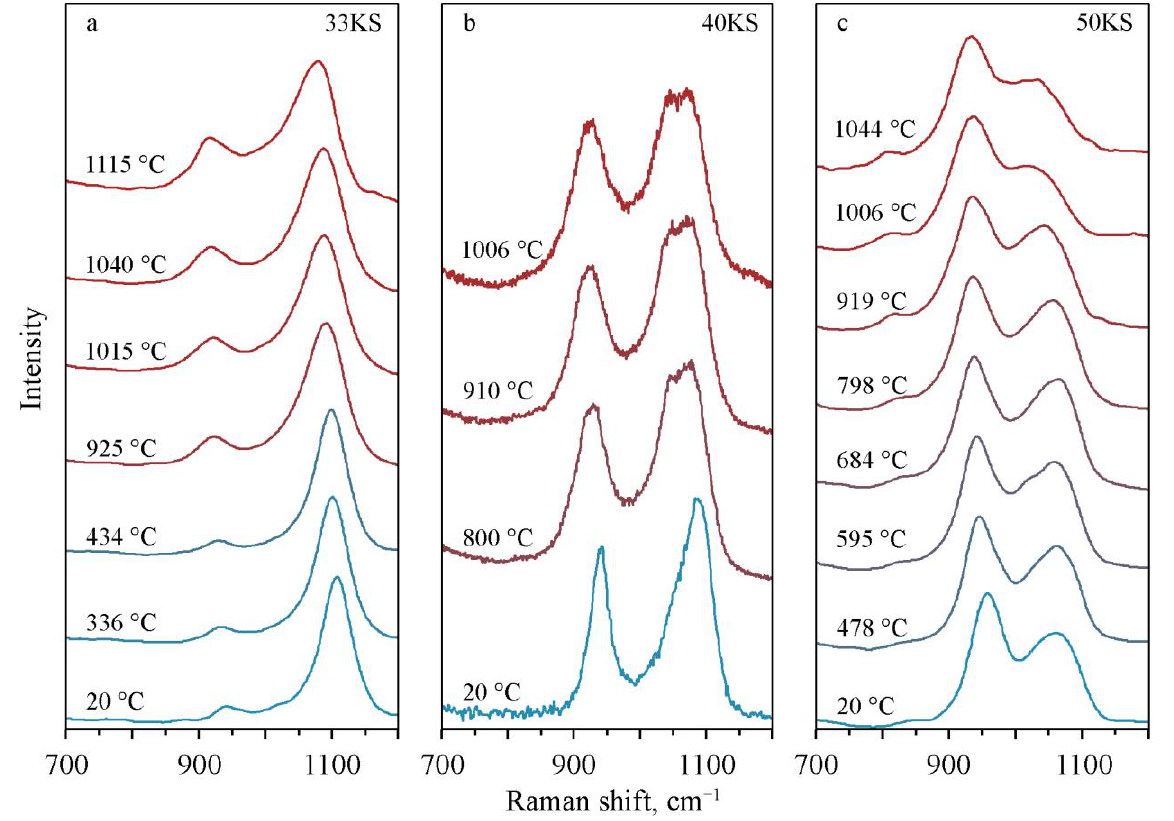
Figure 2. Raman scattering spectra of glasses and melts of the compositions: 33KS ( a ), 40KS ( b ) and 50KS ( c ), depending on temperature [18,33].